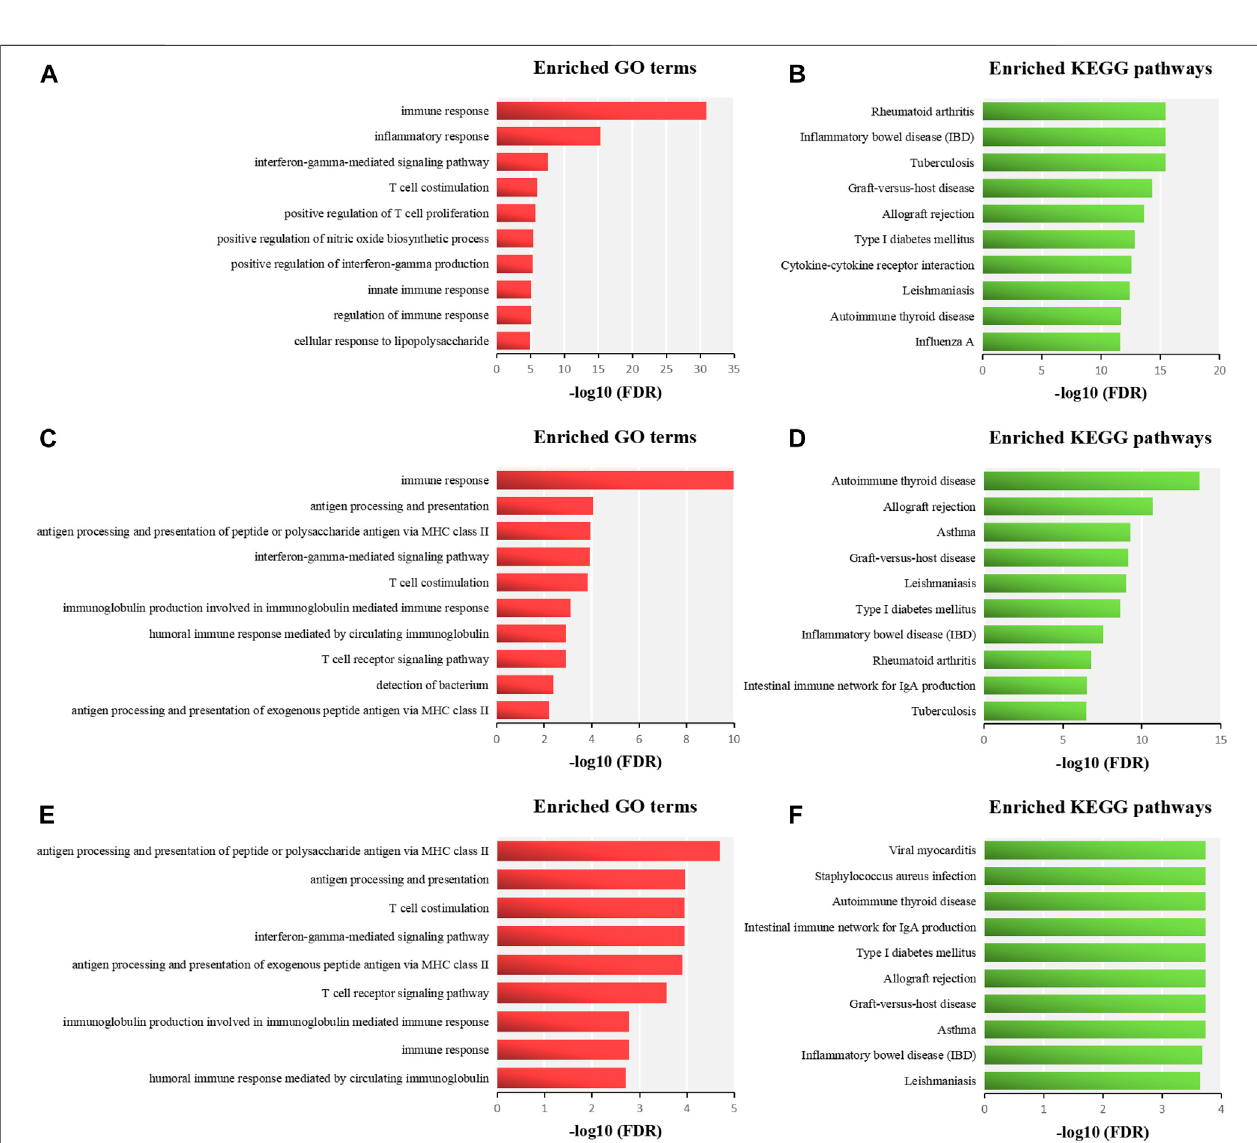
FIGURE5| Functional enrichment analysisofrelated genesofRAand SLE (A-B) ,MGand AIT (C-D) ,and APand VKH (E-F) . Enriched functionalterms aresorted indescendingorderaccordingtotheir – log10(FDR),andthetoptensigni fi cantGOtermsintheBPandKEGGpathwaysofeachsigni fi cantpairofsimilarADsareusedfor further